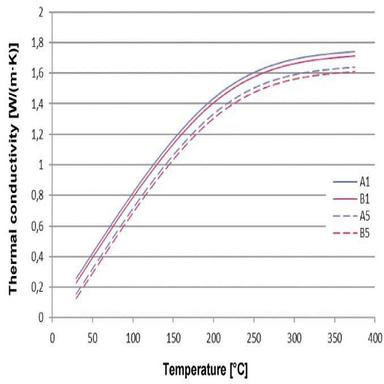
Estimated thermal conductivity as function of temperature of base coated (A1, B1) and nano-coated (A5, B5) ceramic material.